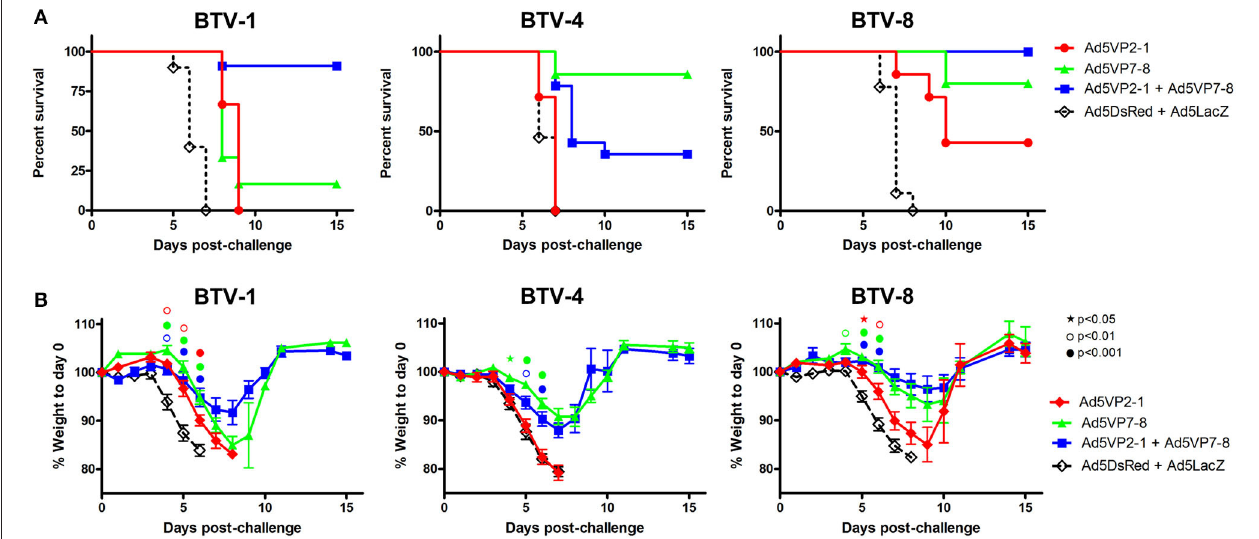
FIGURE 2 | The Ad5VP2-1 and Ad5VP7-8 immunization confers protection against autologous and heterologous BTV challenges. IFNAR ( − / − ) mice were immunized with Ad5VP2-1, Ad5VP7-8, Ad5VP2-1 + AdV5P7-8, or with Ad5DsRed + Ad5LacZ as control and challenged with 1,000 PFU of BTV-1, BTV-4, or BTV-8. (A) Survival plots for each immunization group after BTV challenge (serotype indicated above survival graphs). (B) Mouse weight post-challenge (mean % to prechallenge weight ± SEM) are plotted for each immunized group after BTV serotype challenge (indicated above graphs). Statistical comparison was performed up to day 6 with an intact group of animals. ⋆ p < 0.05; ◦ p < 0.01; • p < 0.001; symbol color refers to immunization group (red, Ad5VP2-1; green, Ad5VP7-8; and blue, Ad5VP2-1 + Ad5VP7-8); one-way ANOVA with Tukey post-test (Ad5VP2-1; Ad5VP7-8; or Ad5VP2-1 + Ad5VP7-8 vs. Ad5DsRed +